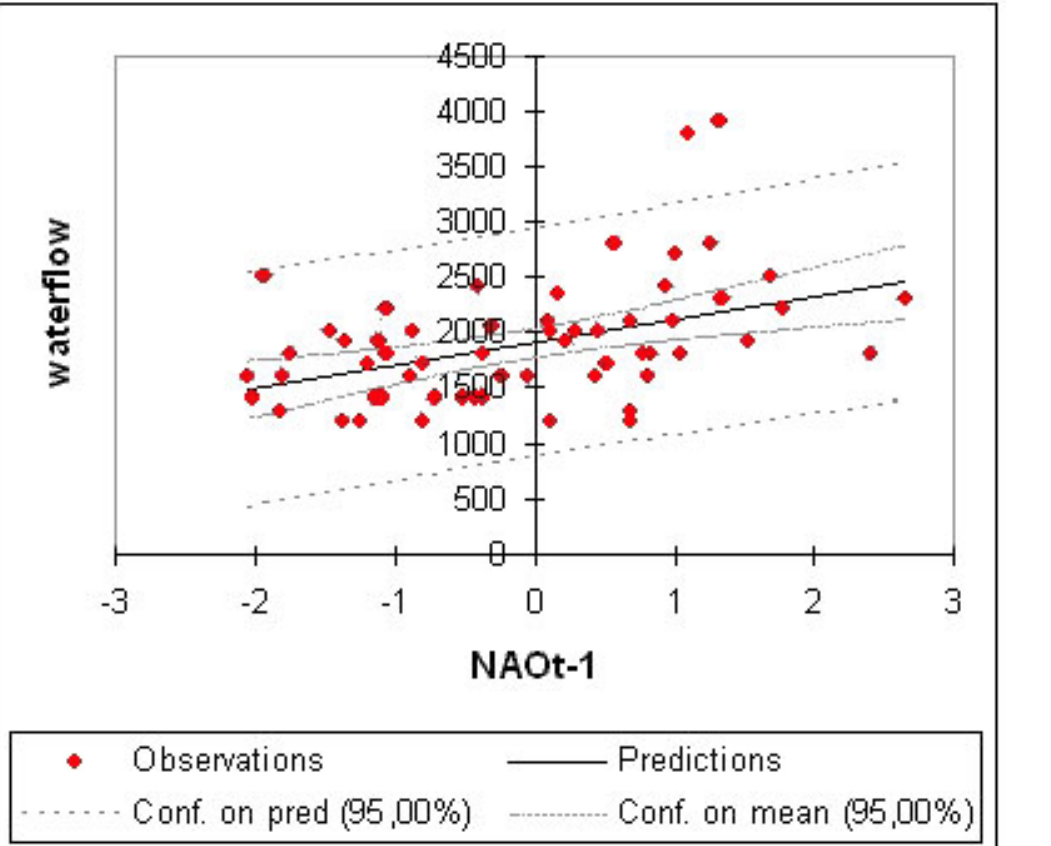
Fig. 3. Water flow in the Ångerman river in relation to the previous winter's North Atlantic Oscillation index. Linear regression equation: Y = 1898.4 + 208.01 x , r 2 = 0.183, F = 13.01, p < 0.001. Red dots represent observations, solid black lines represent predictions, dotted lines show a 95% confidence limit for predictions, and solid gray lines show a 95% limit for the